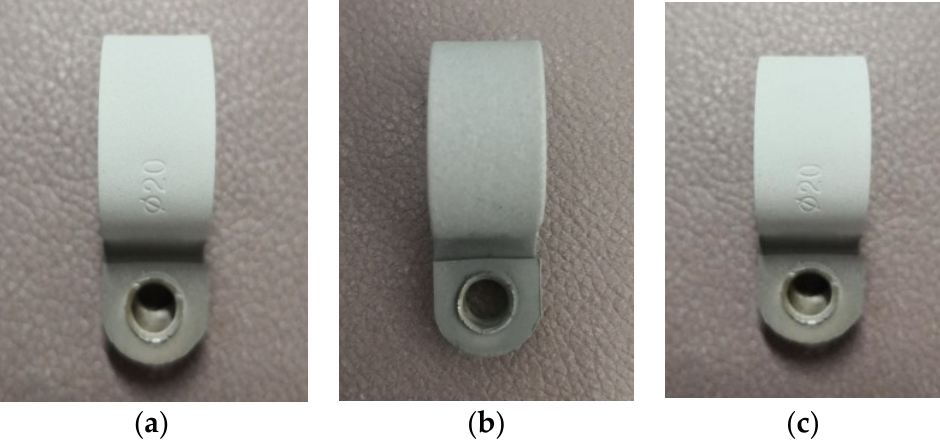
Figure 1. Photographs of the clamps after coating. ( a ) YSZ-coated clamp; ( b ) clamps with quasicrys- talline metal coating; ( c ) YSZ-PTFE-coated clamp.